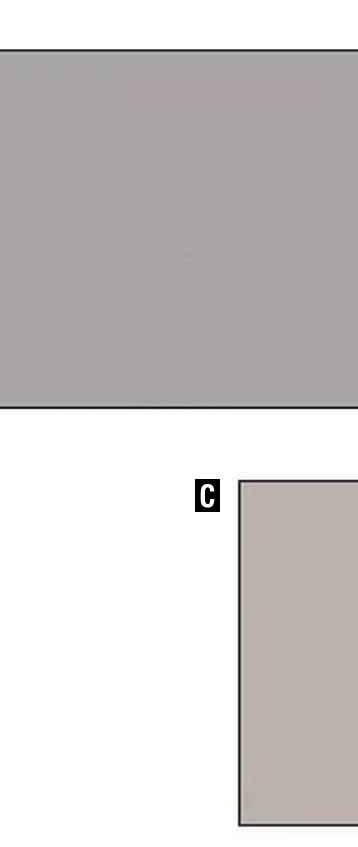
Figure 4 - Polarization micrograph of rat’s urine